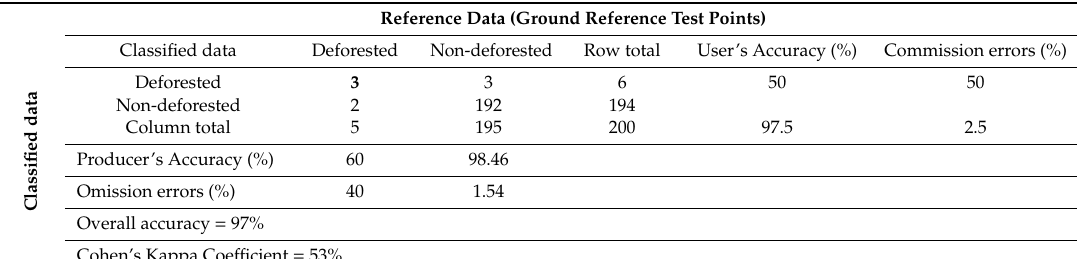
Table 2. Classification error matrix for Global Forest Change (GFC) dataset for Central